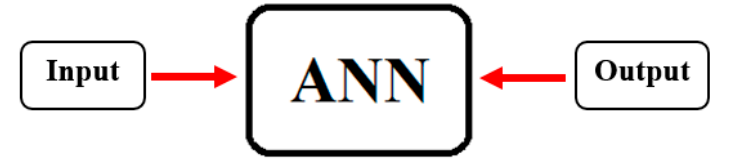
Figure 7. Training stage flow chart.